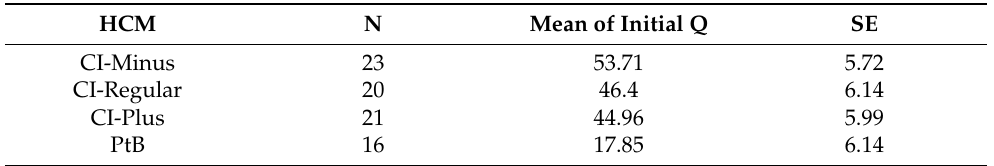
Table 1. Contains the four types of HCM electrodes with the number of electrodes tested (N), mean of initial Q values (Mean of Initial Q), and the standard error